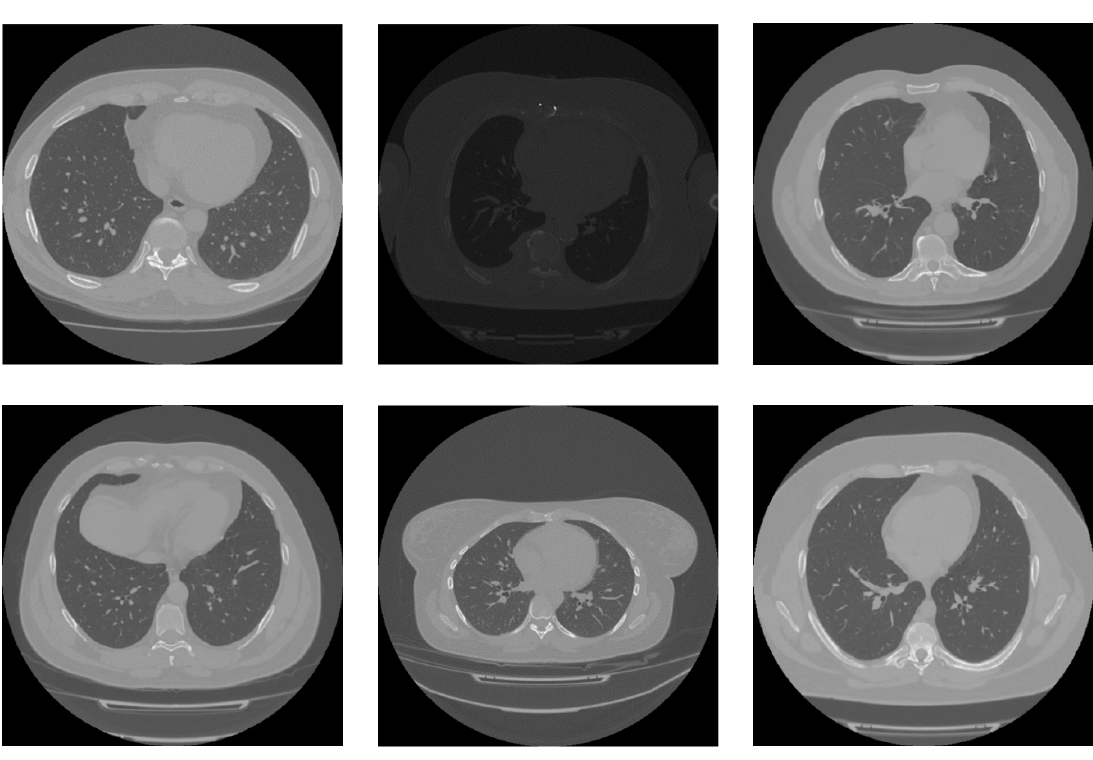
Figure 3. Viral Pneumonia Sample CT scans.